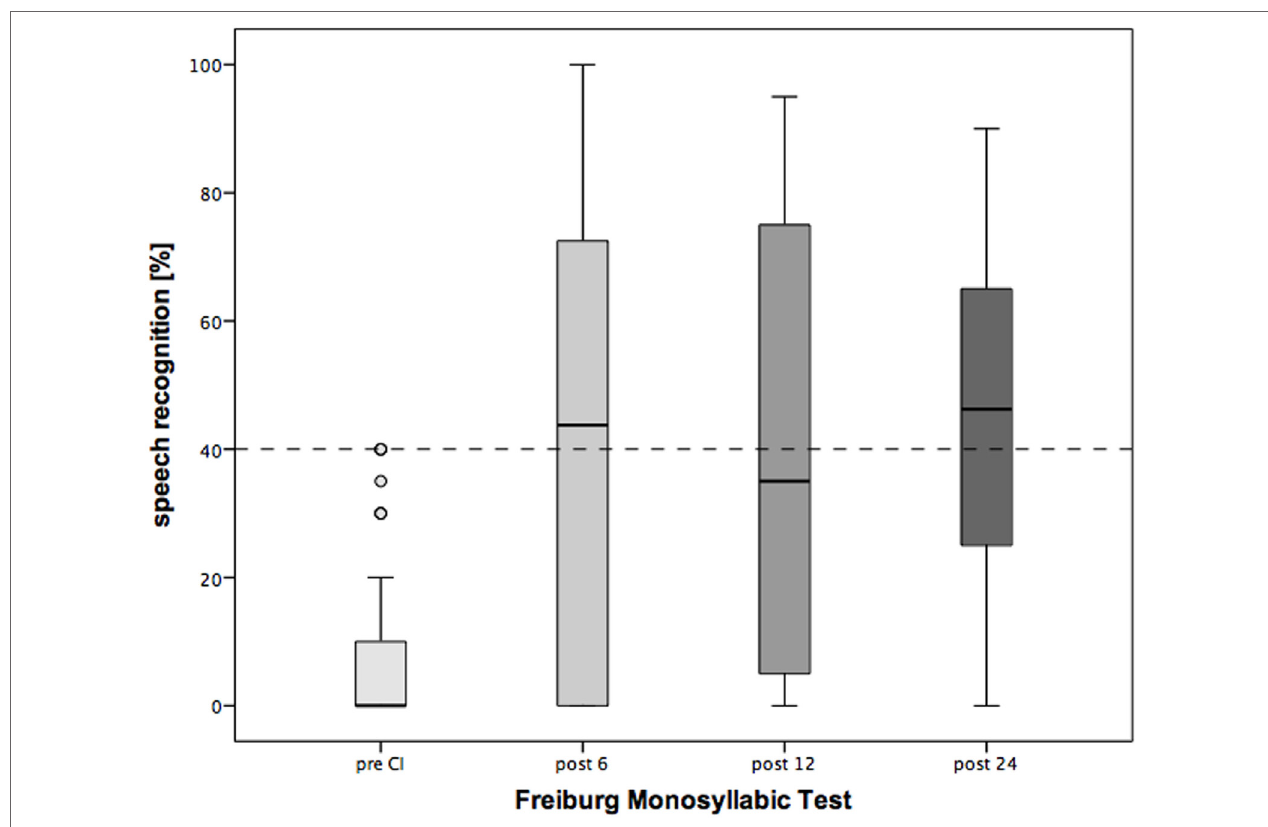
FigUre 5 | changes in speech recognition over the period of 2 years following cochlear implantation (ci) . Shown are mean values and the range. Shown are mean values and the 95% CI. Dotted line: clinical criteria for